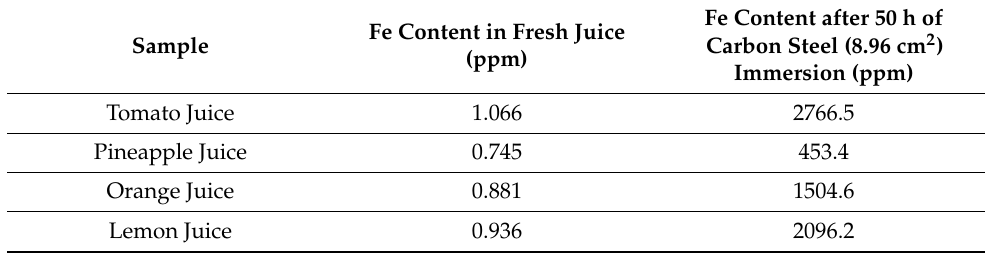
Table 3. Atomic absorption spectrometry results of Fe content in fruit juices before and after 50 h of immersion of carbon steel samples with a surface area of 8.96 cm 2